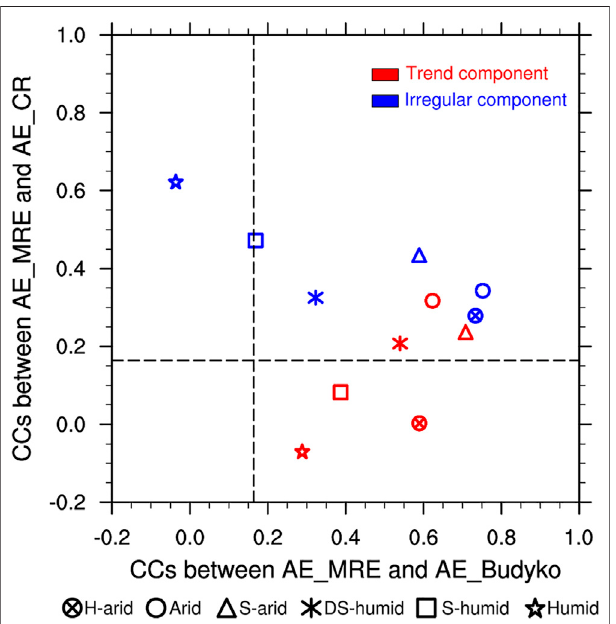
FIGURE4| Plotofcorrelationcoef fi cientsbetweenAE_WARandAE_CRvs correlation coef fi cients between AE_WAR and AE_Budyko in six climatic areas of Chinafrom1982to2015fortheX-12-ARIMAtrendandirregularcomponents.The local 99.9% con fi dence levels are about ± 0.164 based on Student ’ s t- test.